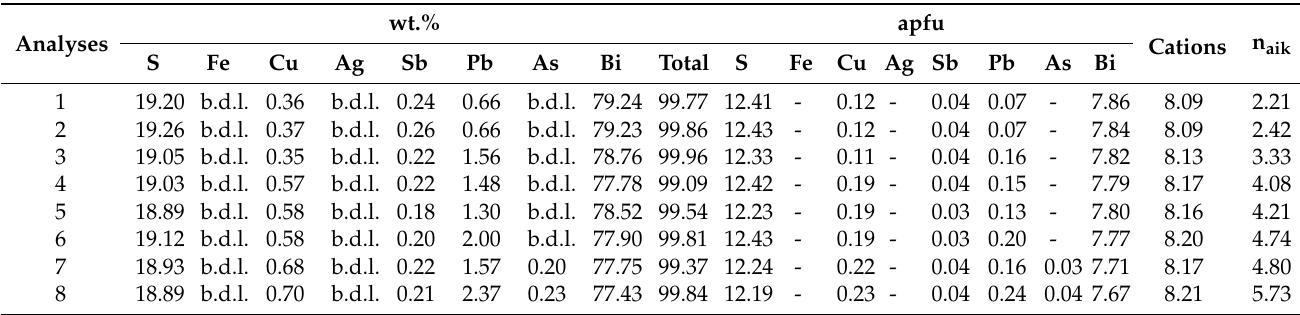
Table 6. Representative EPMA data for bismuthinite from the Kizhnica hornfels. The empirical formula was calculated based on the sum Ag + Bi + Sb + Fe + As + (Pb + Cu)/2 = 8 atoms, b.d.l. = below detection limit.